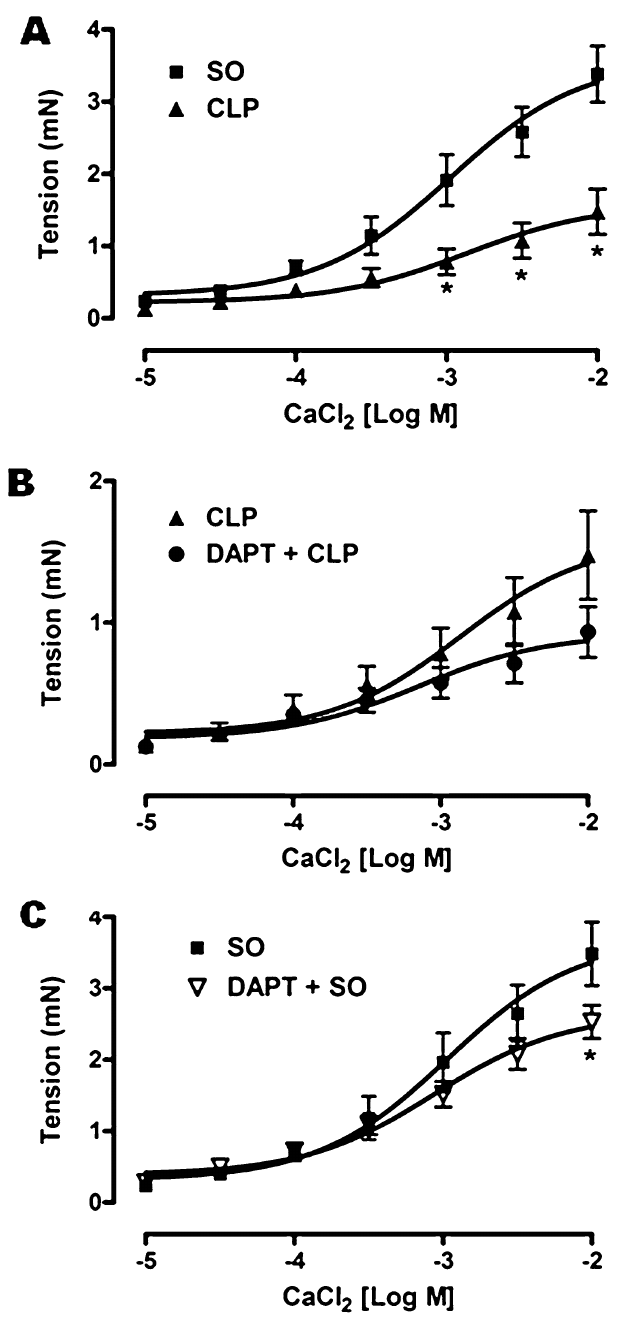
Figure 9. Effect of DAPT pre-treatment on hyporeactivity of the aortic ring to calcium-chloride (CaCl 2 ) in septic mice. Comparative line diagrams ( A – C ) showing the mean concentration–response curves of CaCl 2 on the aorta isolated from sham-operated (SO), sepsis (CLP), DAPT pre-treated sepsis (DAPT + CLP) and DAPT pre-treated SO (DAPT + SO) groups. Data are presented as mean ± SEM; n = 6. Vertical bars represent SEM. Data were analyzed by two-way ANOVA followed by Bonferroni post-hoc tests. * p < 0.05 in comparison to